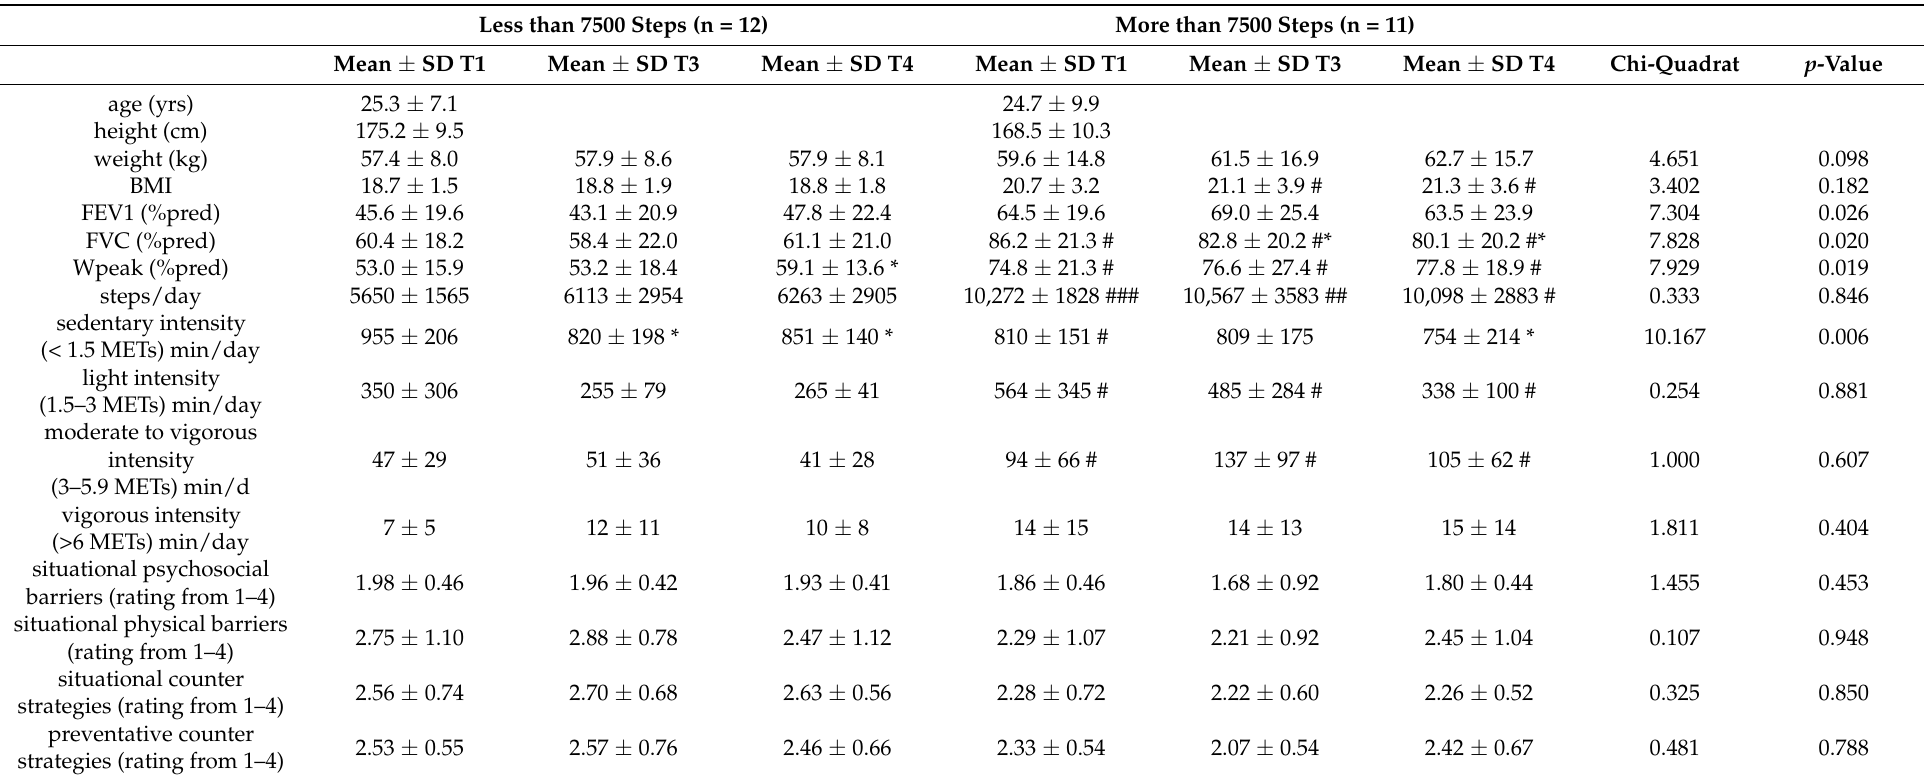
Table 5. Anthropometric characteristics, lung function and steps/day, and intensity of physical exercise of participants by less than 7500 steps and more than 7500 steps during the monitored exercise program